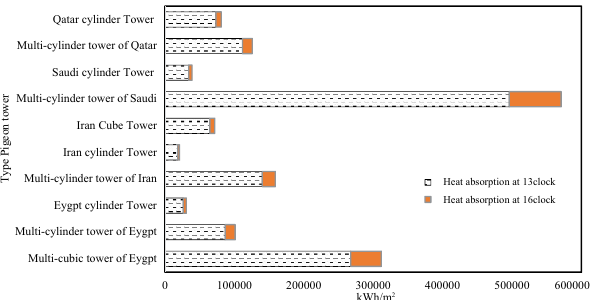
Figure 3. Total heat absorption by the surfaces of the pigeon